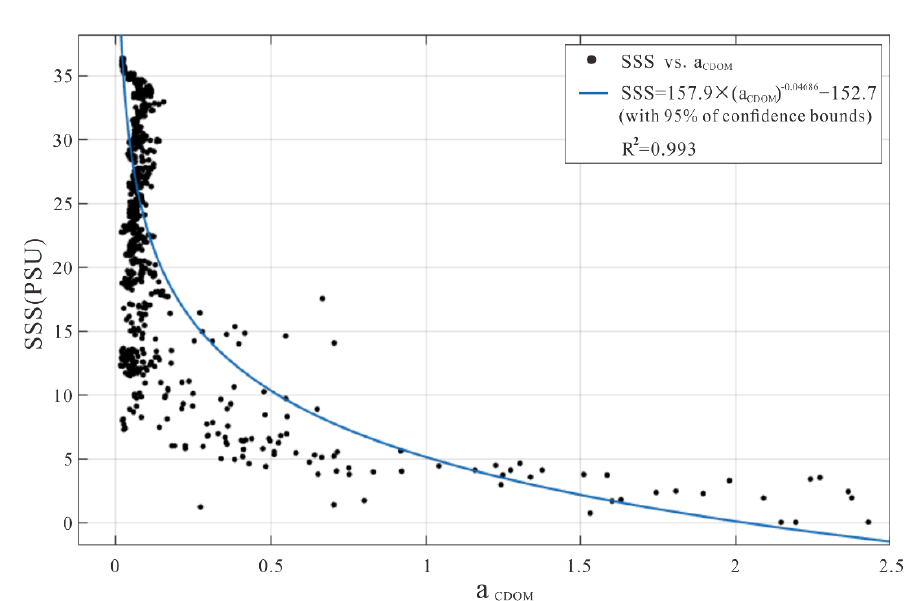
Figure 2. The fitting relationship image between SSS and a CDOM (with 95% confidence bounds). The horizontal axis represents a CDOM (unit: m − 1 ), whereas the ordinate represents the measured salinity value (unit: PSU).